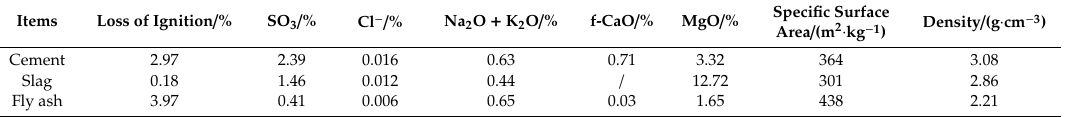
Table 1. Physical properties and chemical composition of cement, slag powder and fly ash.